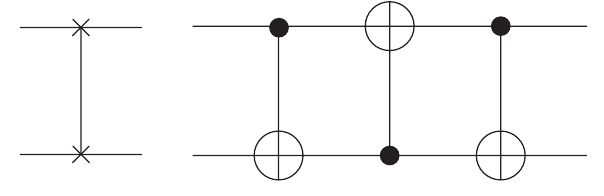
Figure 1: SWAP gate using CNOT